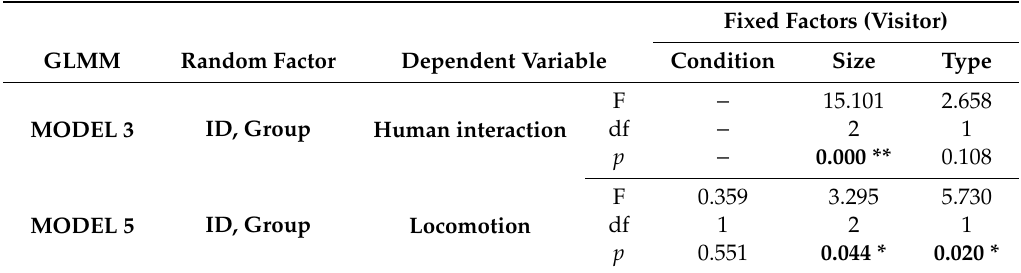
Table 6. Behavior of the chimpanzees significantly a ff ected by aspects of the visitor groups.